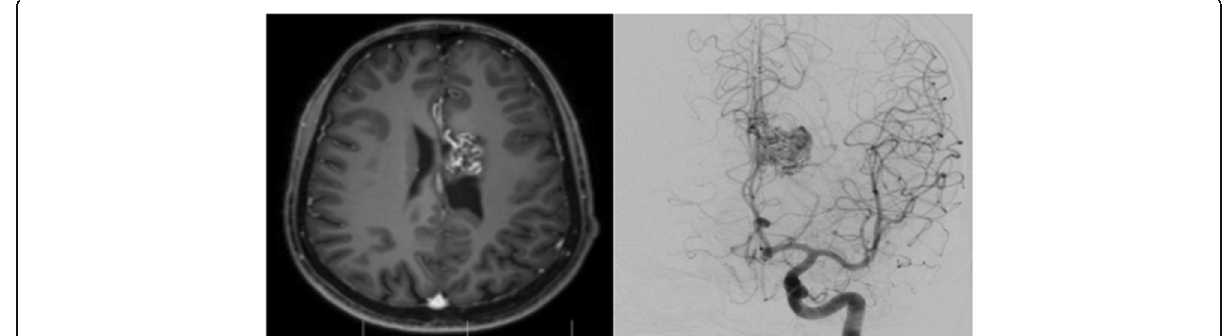
Fig. 6 A parasagittal AVM being fed from the